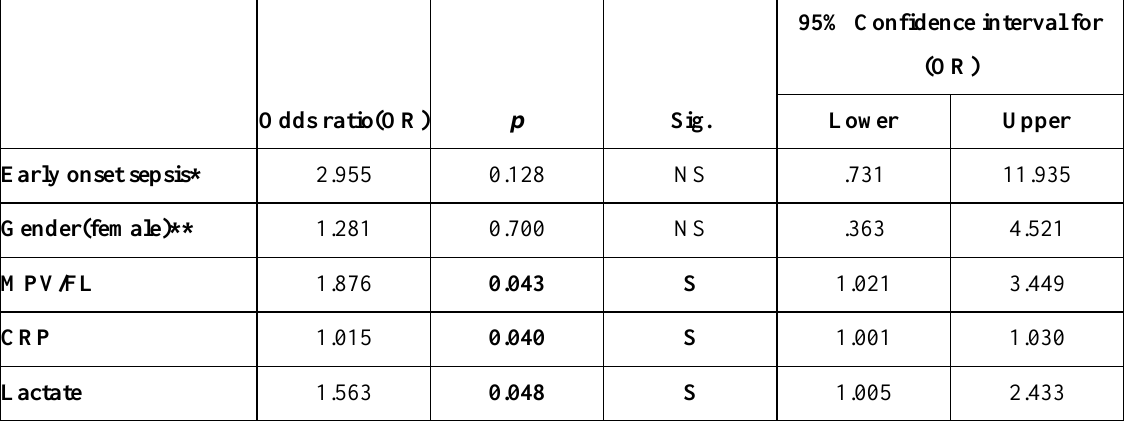
Table 6. Logistic regression for studying independent factors associated with Gram negative blood culture